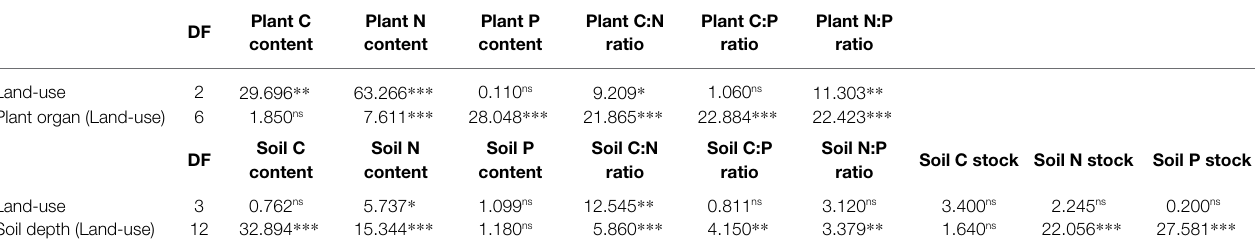
TABLE 2 | Nested ANOVA results for the effects of different land-use types, plant organs, and soil depths and on the C, N, and P contents and ratios, and C, N, and P stocks. DF